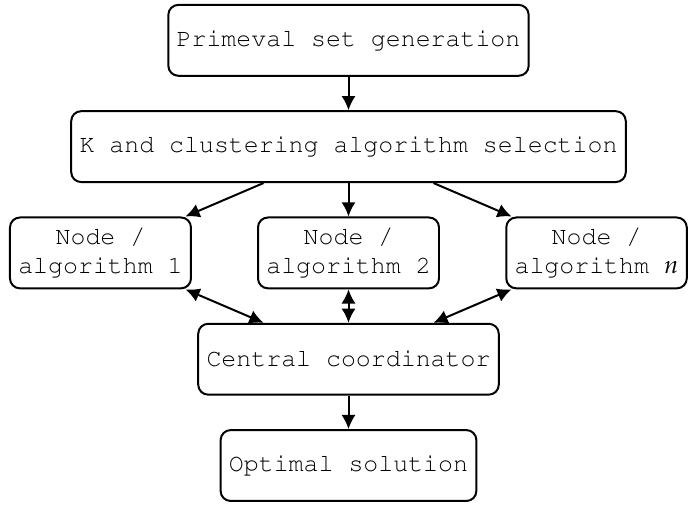
Figure 1. Collaboration